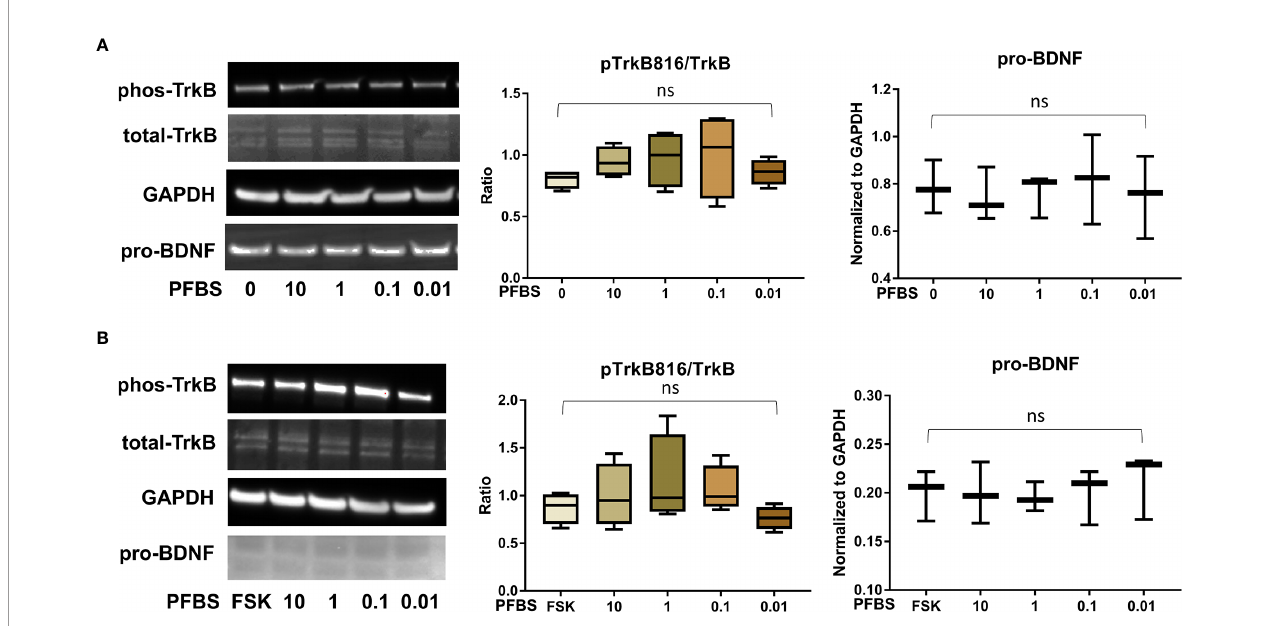
FIGURE 5 | PFBS exposure did not signi fi cantly disrupt the BDNF-TrkB pathway. (A) Representative Western blot images of phos-TrkB, total-TrkB, GAPDH, and pro-BDNF in BeWo cells without forskolin (FSK) treatment exposed to PFBS (0, 0.01, 0.1, 1, and 10 µM) and box plots for densitometry analysis; (B) Representative Western blot images of phos-TrkB, total-TrkB, GAPDH, and pro-BDNF in BeWo cells with FSK treatment exposed to PFBS (0, 0.01, 0.1, 1, and 10 µM) and box plots for densitometry analysis. ns indicates differences in protein levels were not signi fi cant. pTrkB816 represents for phosphorylation of TrkB at Tyr816 residue.